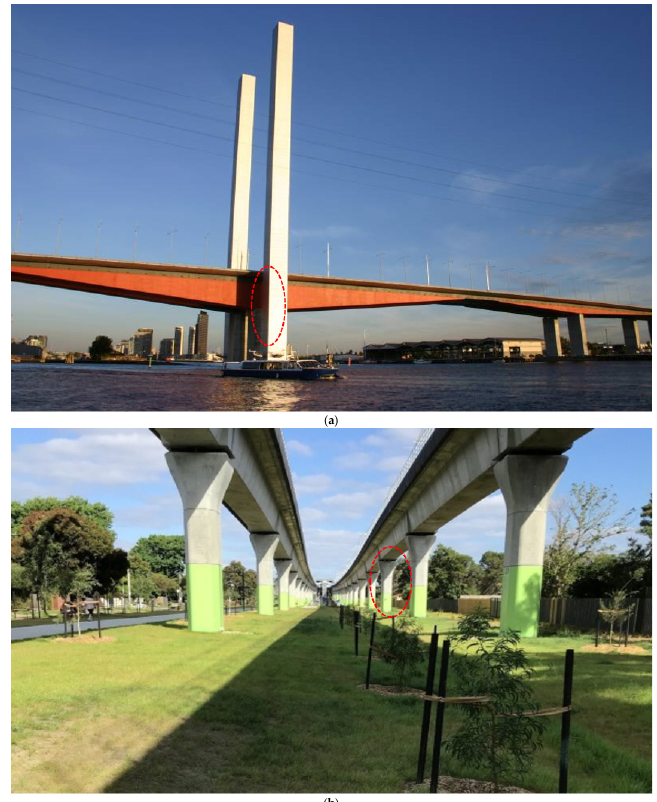
Figure 1. The images of ( a ) Bolte Bridge and ( b ) sky rail areas in Victoria (Melbourne).